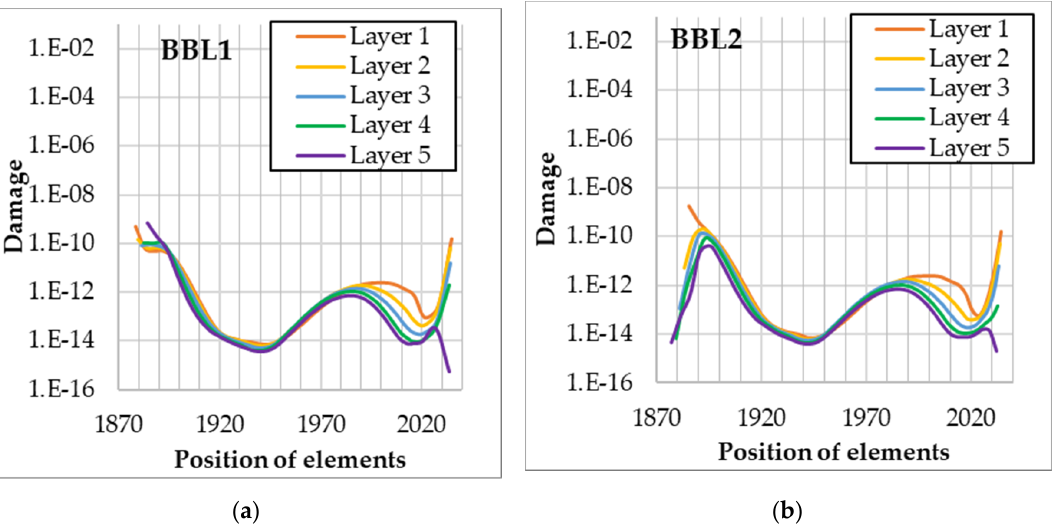
Figure 14. Damage of two other models with different chamfers: ( a ) Damage of the BBL1 model; ( b ) Damage of the BBL2 model.